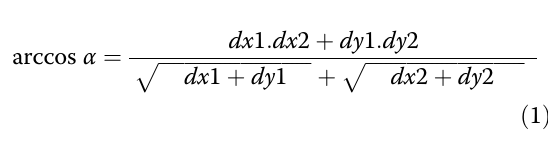
fuzzy logic input. α is the angle of two vehicles is cal- culated via Eq 1.